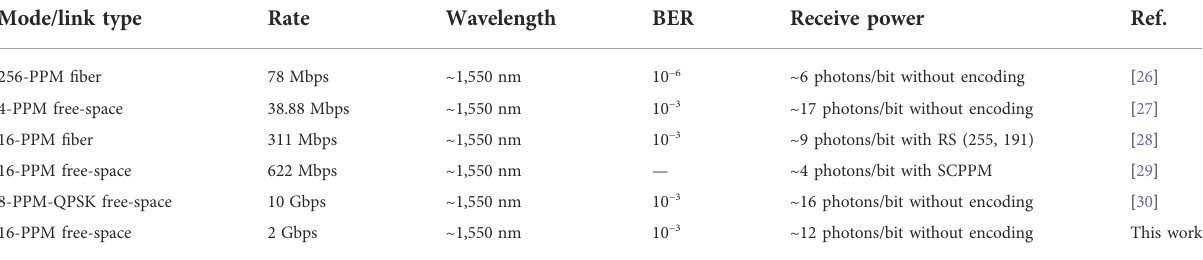
TABLE 2 Reported BER results for different PPM